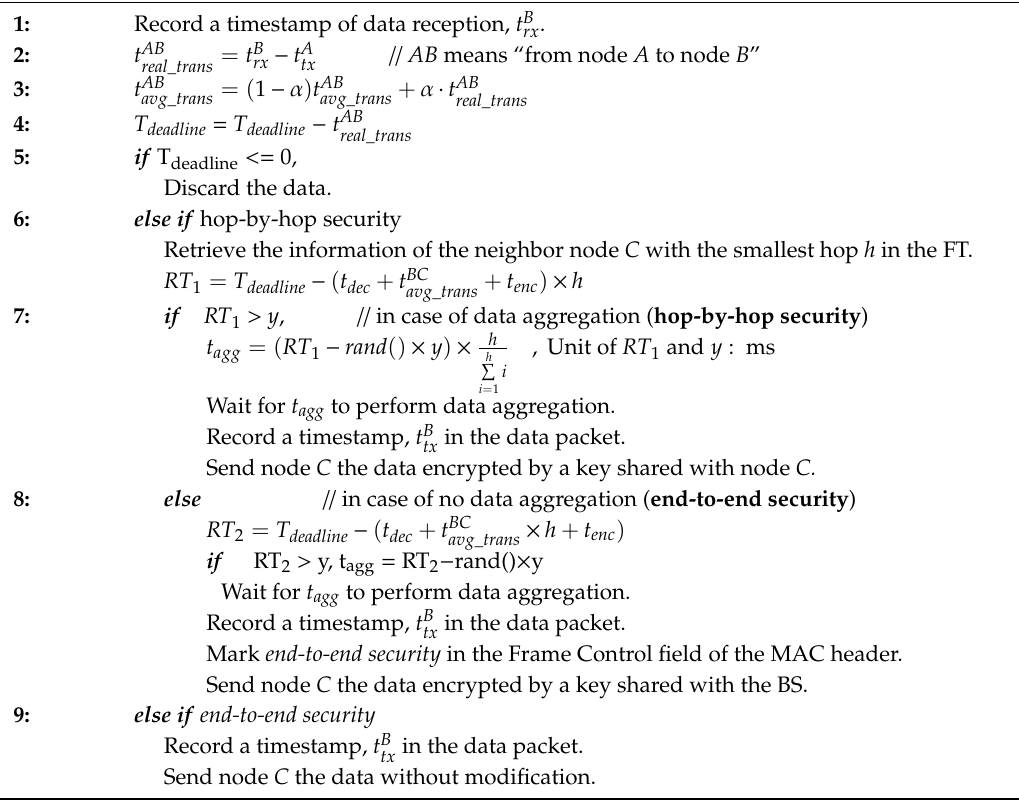
Algorithm 1 Operations of node B upon receiving sensing data from node A